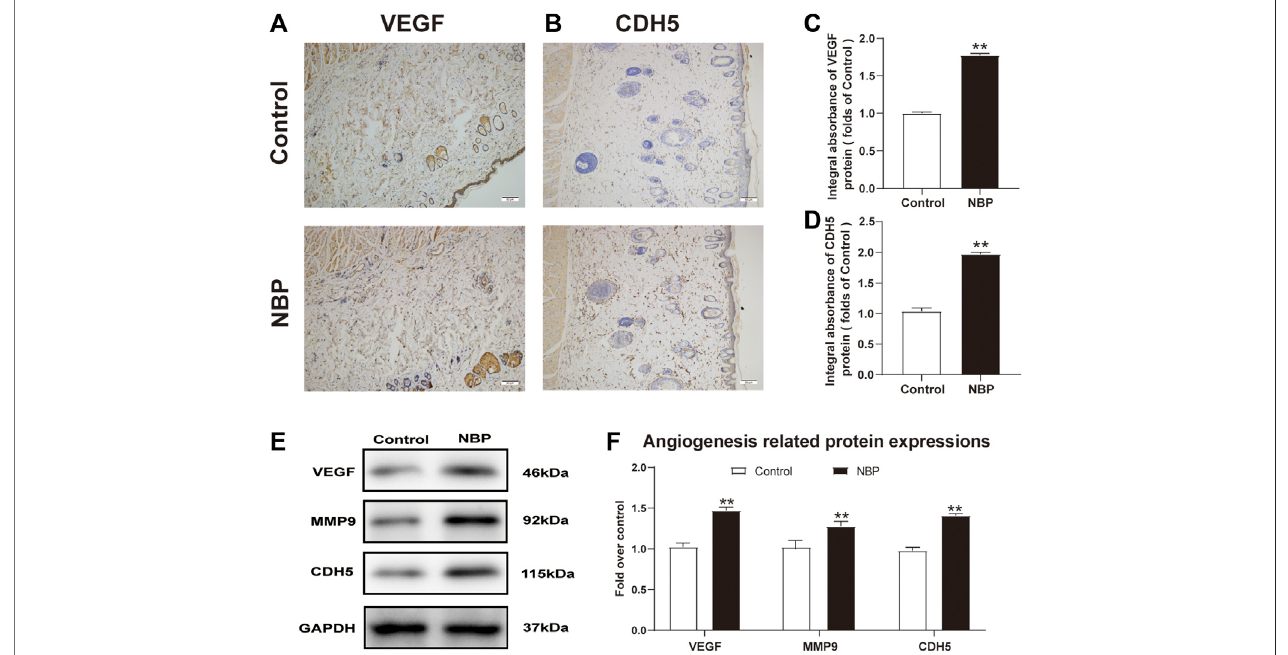
FIGURE2| NBPimprovesangiogenesisinmultiterritoryperforator fl ap. (A) and (B) IHCofVEGFandCDH5intheischemic fl apofthecontrolandNBP-treatedrats. (C) and (D) Optical density values ofVEGFand CDH5. (E) Western blotting ofMMP9, VEGF, and CDH5in control and NBP-treated groups. (F) Opticaldensity valuesof MMP9, VEGF, and CDH5 from western blot. Gels were run under similar experimental conditions and cropped edited only forclarity. Values are shown asmean ± SEM, n (cid:1) 6 per group. * p < 0.05 and ** p < 0.01 vs. control group.